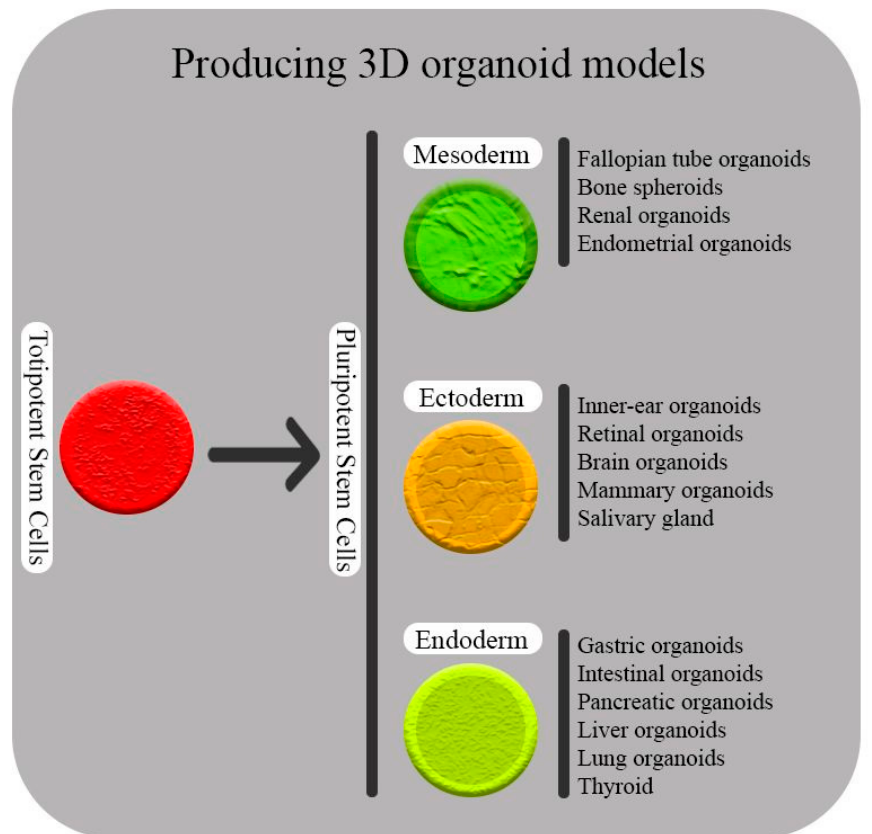
Figure 1. The zygote cell and its initial divisions (embryonic cells), which are considered totipotent stem cells, have the capacity to give rise to fully developed living organisms (body and placenta). Pluripotent stem cells, which can generate all cells that make up a live organism’s body following totipotent stem cells, are the next stage (mesoderm, endoderm, and ectoderm). Organoids are the new era for disease modeling, homeostasis, and development studies. Organoids derived from mesoderm, endoderm, and ectoderm are considered a new field of interest in biomedical research.